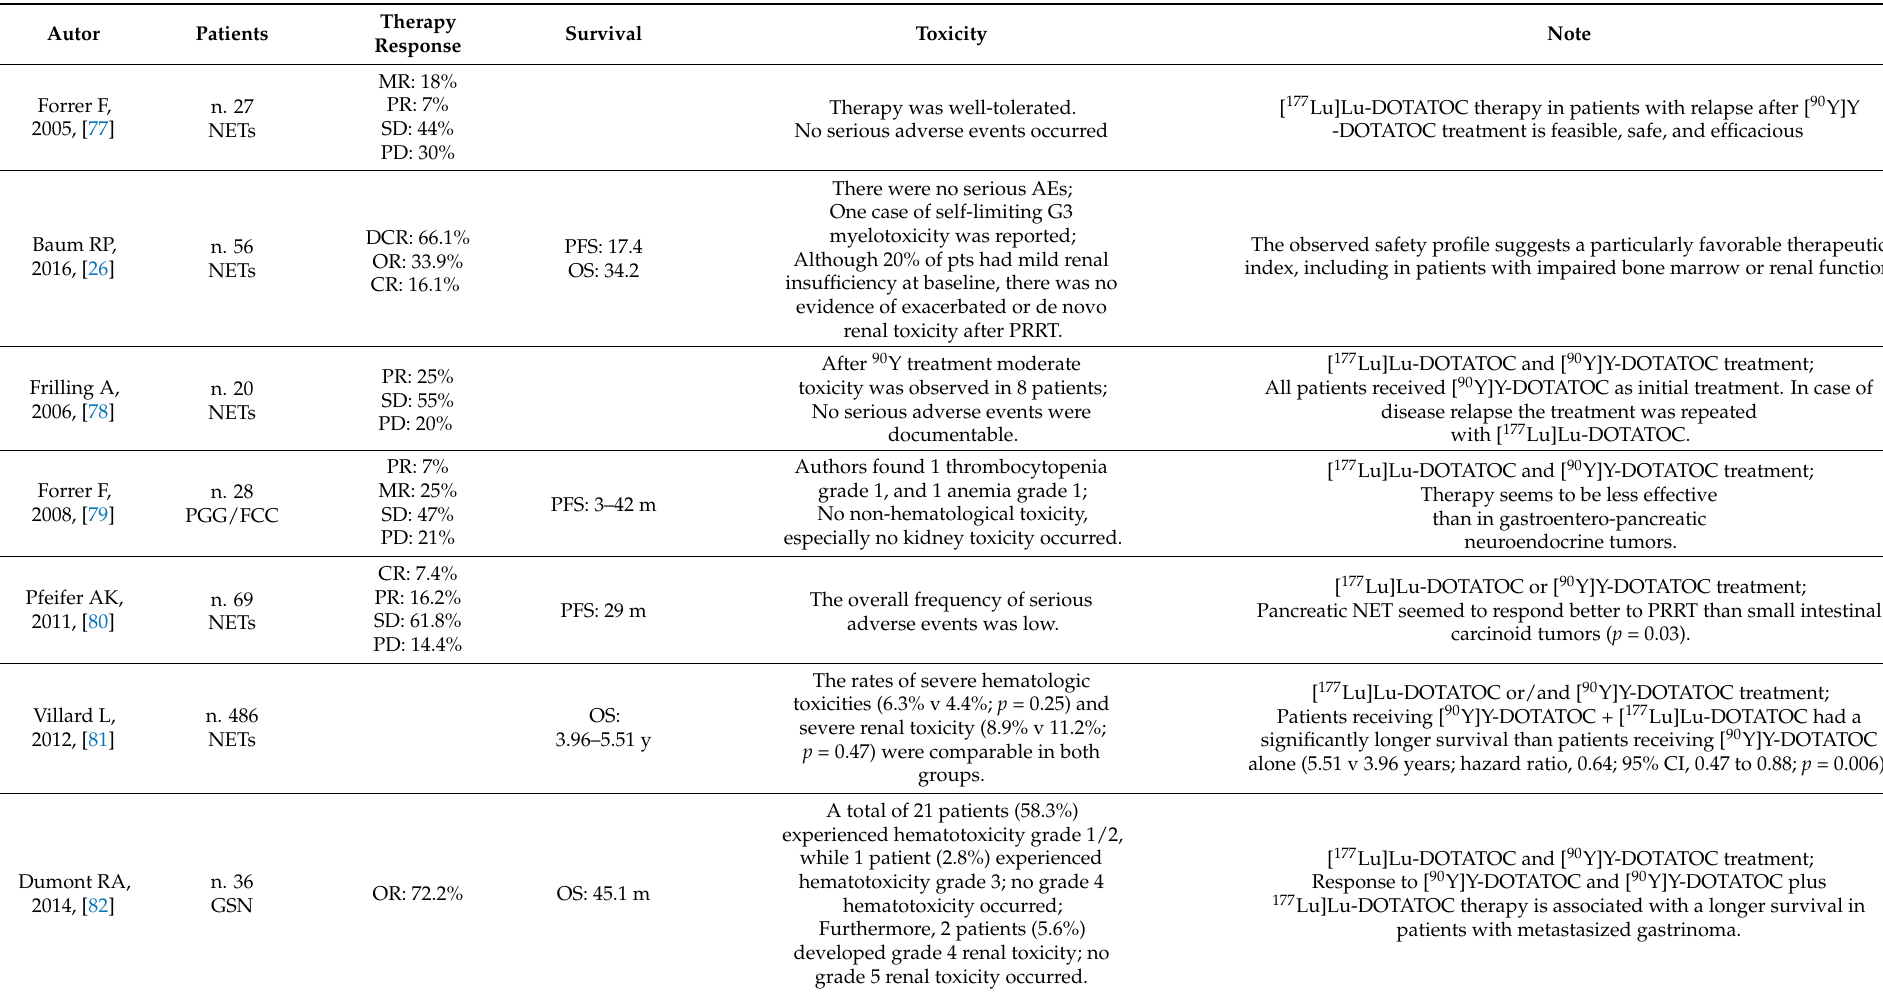
Table 5. The main studies in which the radiopeptide [ 177 Lu]Lu-DOTATOC was used for the treatment of NETs and other